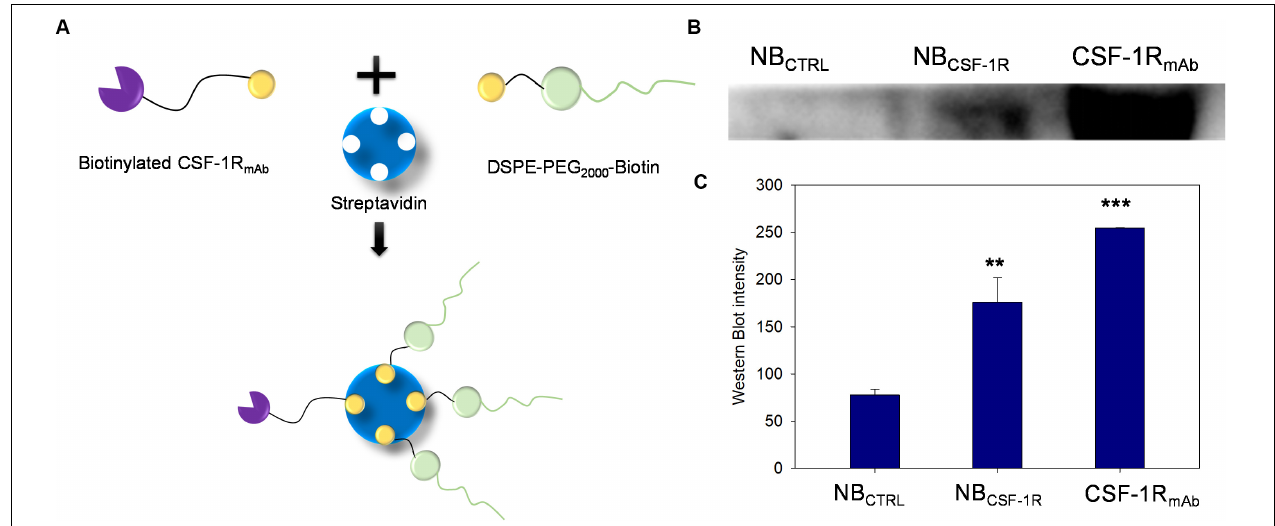
FIGURE 2 | (A) The process of synthesis of nanobubble CSF-1R (NB CSF − 1R ) through the streptavidin/biotin chemical effect, CSF-1R mAb was biotinylated and then conjunction to the 1,2-distearoyl-sn-glycero-3-phosphoethanolamine-N-[biotinyl(polyethylene glycol)-2000] (DSPE-PEG 2000 )-Biotin. (B) Western blot showed that the NB CSF − 1R band was at approximately the same position as CSF-1R mAb , and the NB CTRL showed no expression of CSF-1R. (C) Showed the Western blot intensity of NB CSF − 1R , CSF-1R mAb , NB CTRL (**indicates p < 0.05, ***indicates p <